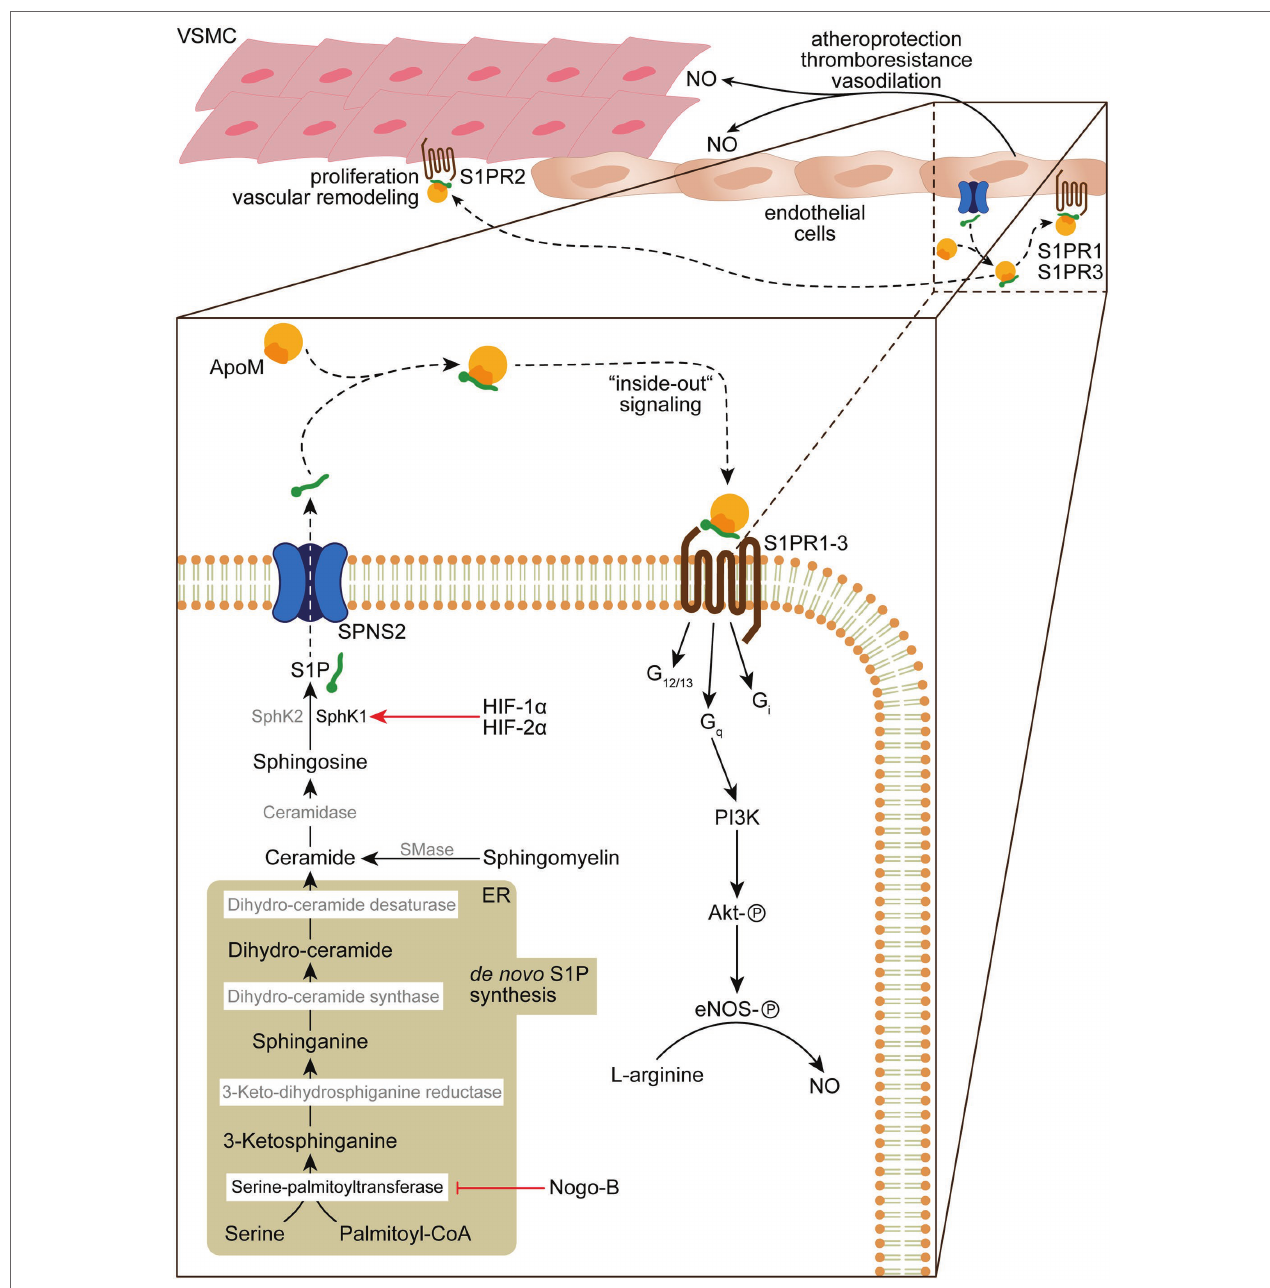
FIGURE 2 | De novo sphingolipid biosynthesis, S1P “inside-out” signaling and its role in vascular homeostasis and function. De novo sphingolipid biosynthesis is initiated in the endoplasmatic reticulum (ER) by condensation of serine and palmitoyl-CoA into 3-ketosphinganine by serine-palmitoyltransferase, which activity can be inhibited by Nogo-B. 3-ketosphinganine is rapidly metabolized into sphinganine by 3-keto-dihydrosphinganine reductase. Subsequently, sphinganine is converted by dihydro-ceramide synthase into dihydro-ceramide, which is desaturated by dihydro-ceramide desaturase into ceramide. The ceramide pool can further be increased by sphingomyelinase (SMase) that catabolizes sphingomyelin in the plasma membrane, which is transformed by ceramidase into sphingosine. In the final step of the S1P biosynthesis sphingosine is phosphorylated by SphK1/SphK2 in order to form S1P, which is released by secretion through SPNS2.